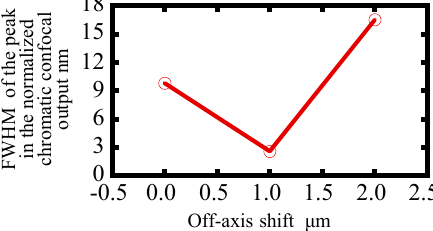
Figure 11. Variation of the FWHM of the peak in the normalized chromatic confocal output due to the change in the off-axis displacement d m of the fiber detector in the reference detector.